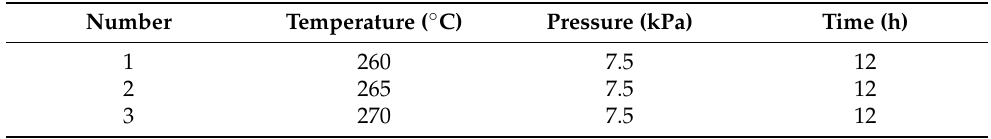
Table 2. Sample hot pressing process